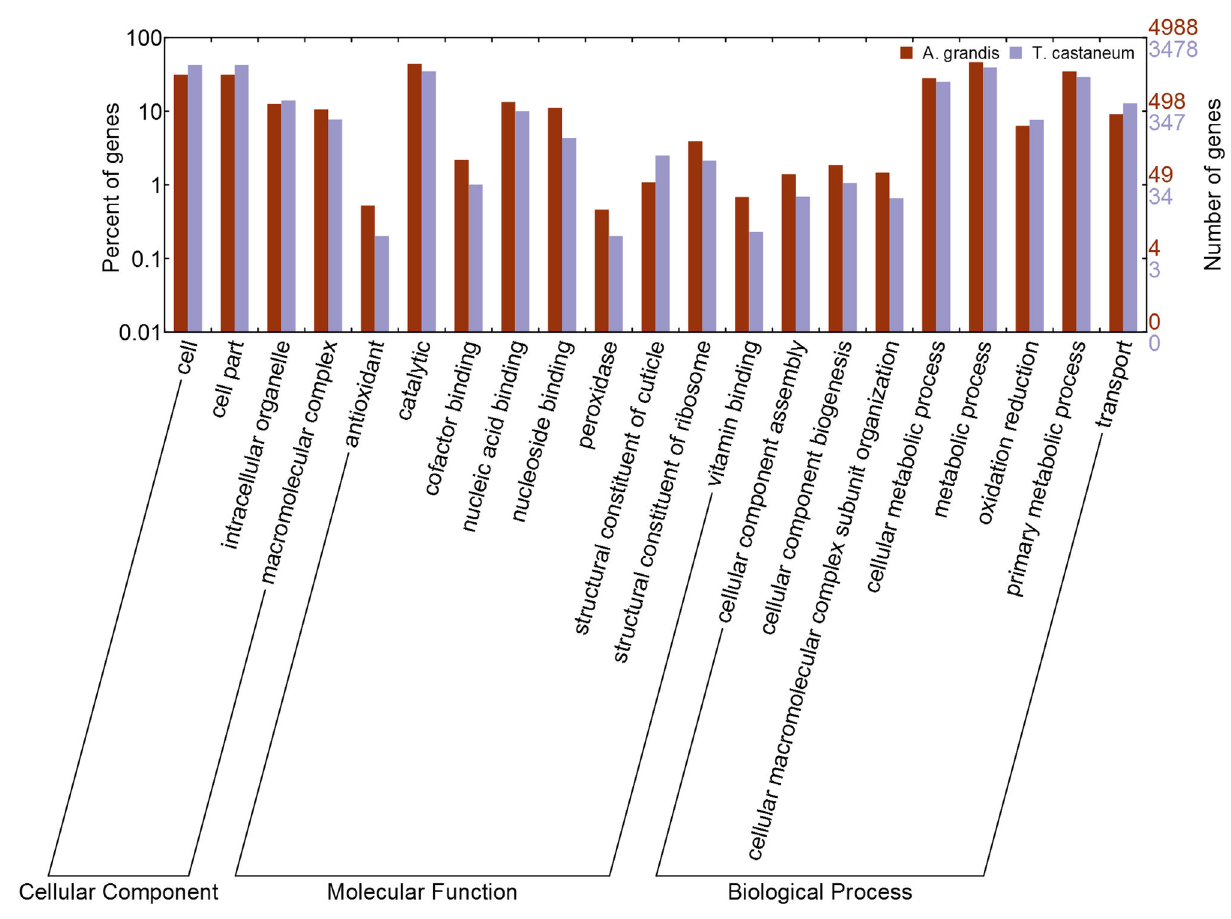
Figure 3. Comparison of the distribution of GO terms. The X-axis shows subgroups of cellular component, molecular functions and biological process from GO. Distribution of GO terms of gene families of T. castaneum and A. grandis are compared. The Y- axis shows the percentage (left) and the number of genes (right) of the matched Pfam entries. doi: